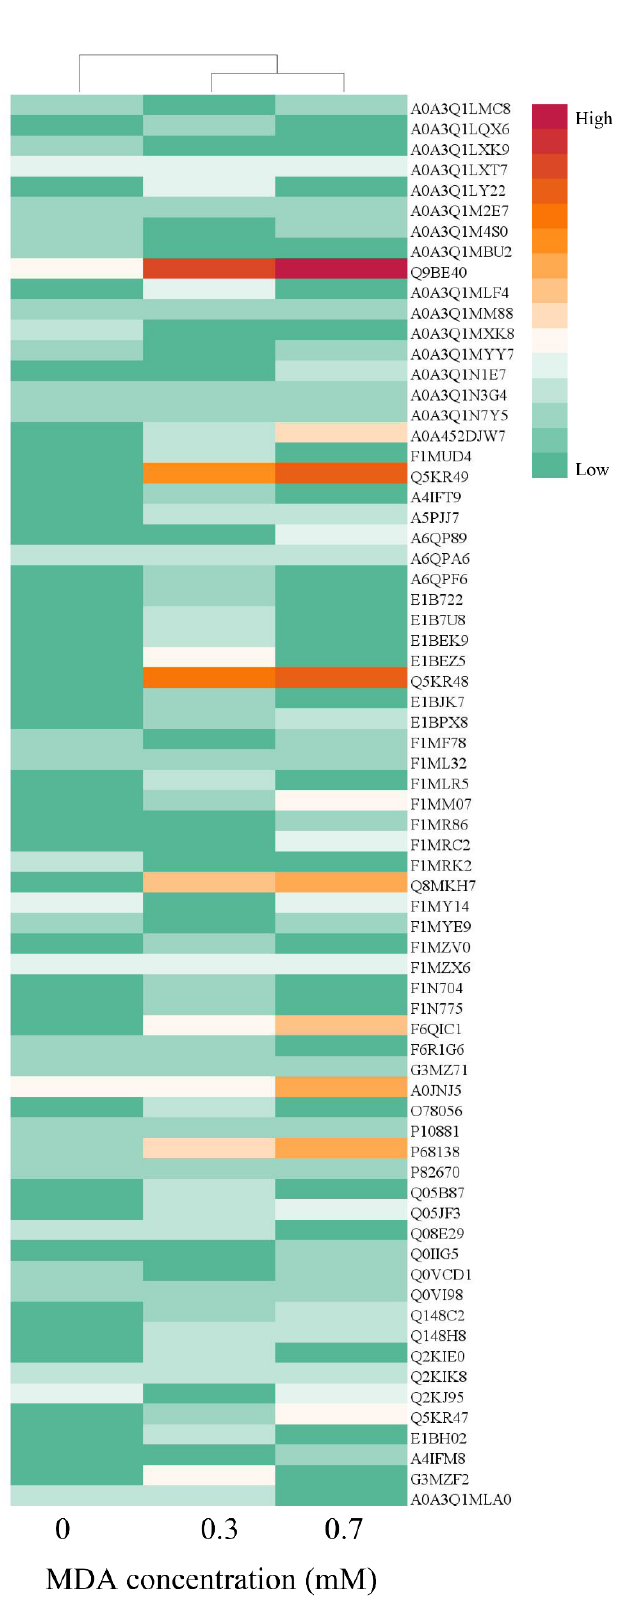
Figure 7. The MDA modified protein profiles displayed by heat map. The red color indicates more modification sites in the corresponding protein, followed by orange, and the green color indicates fewer modification sites.